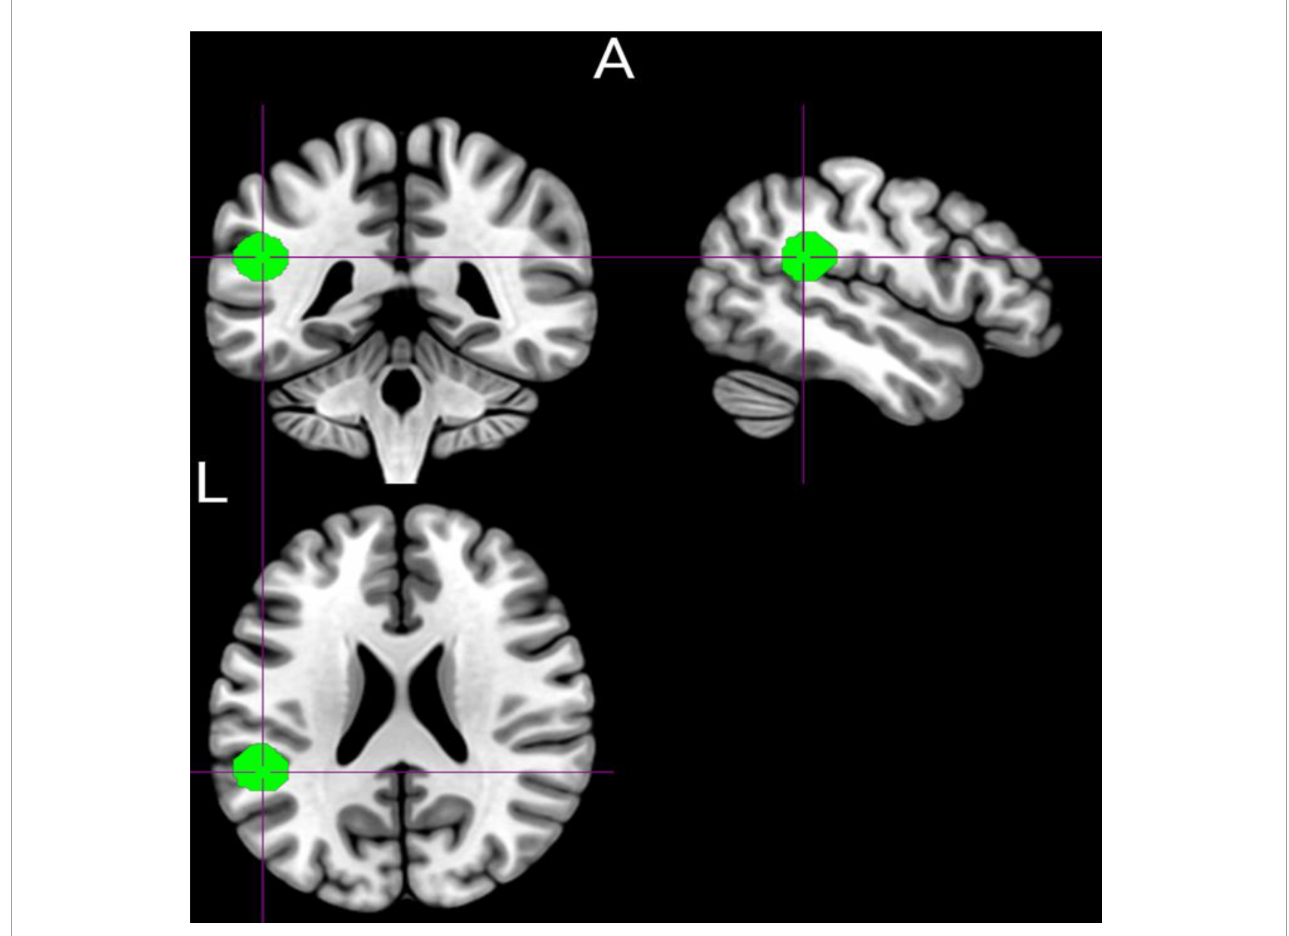
FIGURE1 Graphical representation of the prior defined region of interest (left temporoparietal junction area) was defined using the Marsbar toolbox (MNI: − 50.7, − 41.4,